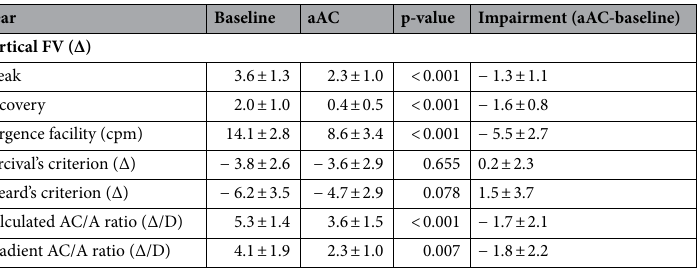
Table 3. Mean values and standard deviations for near vertical fusional vergences, vergence facility, Percival’s and Sheard’s criteria, and AC/A ratio measured at baseline and after alcohol consumption (aAC, BrAC = 0.40 mg/l). Mean impairment values for each parameter and p-values of the mean comparisons are included.